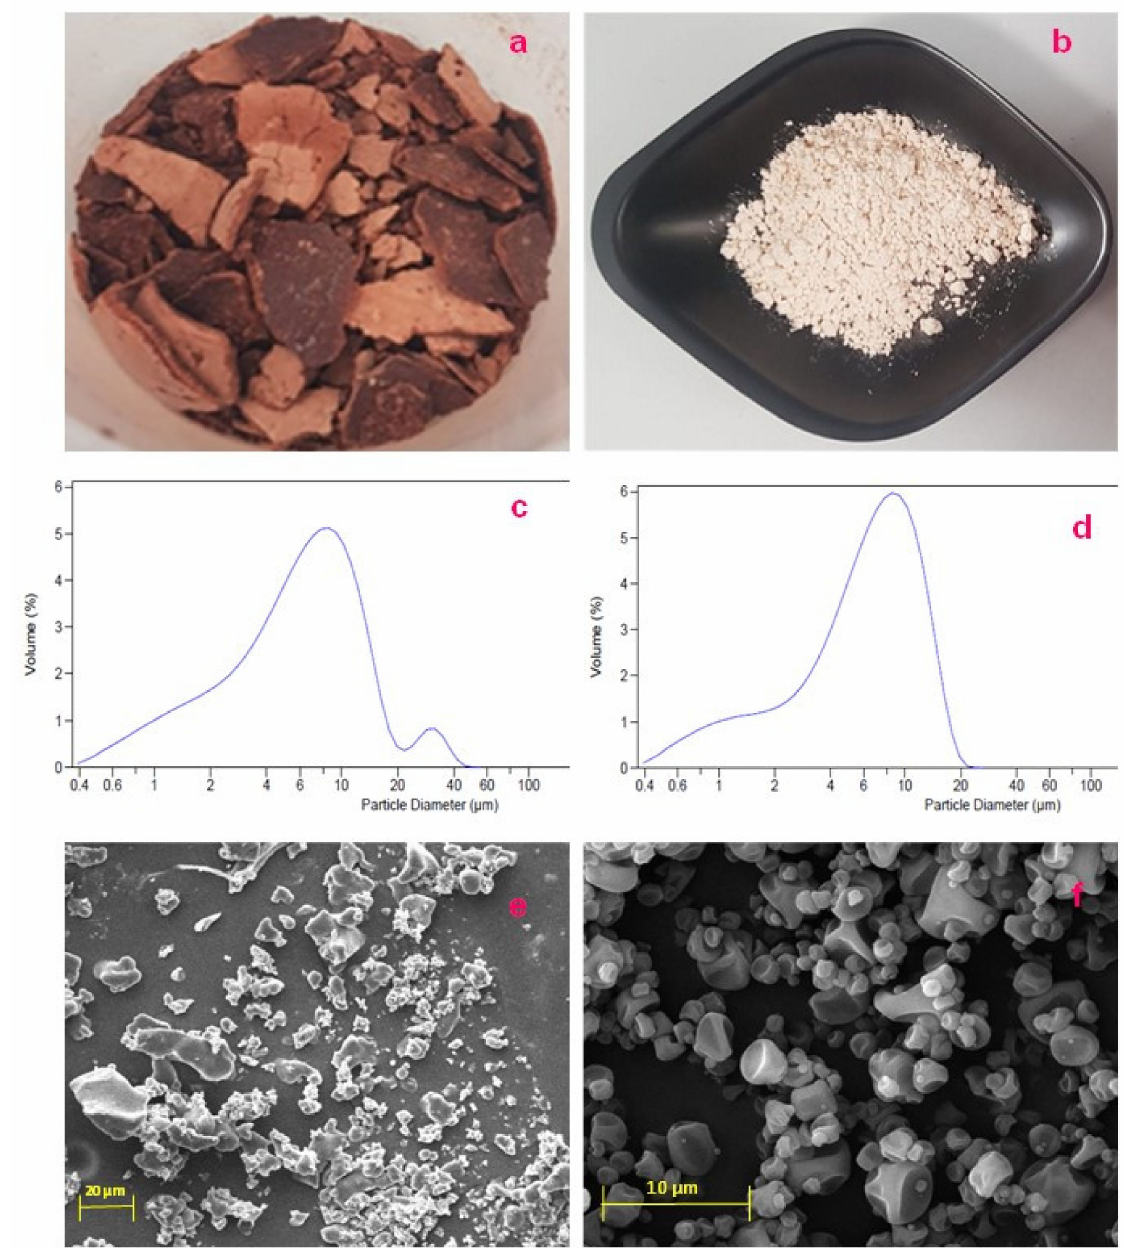
Figure 5. Macroscopic image, dimensional distribution curve and SEM image of lyophilized Aglianico raw extract AGL-28 ( a , c , e ) and MPA powders ( b , d , f